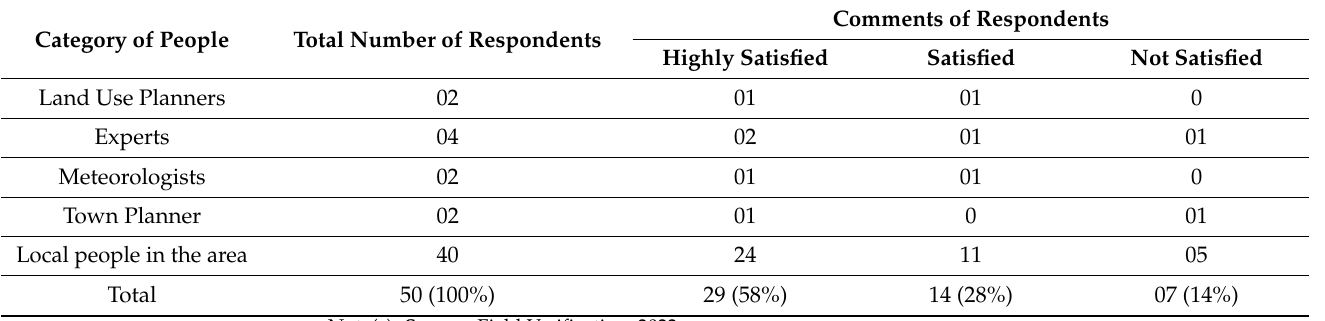
Table 8. Feedback from the people during the field verification of vulnerability assessment. Category of